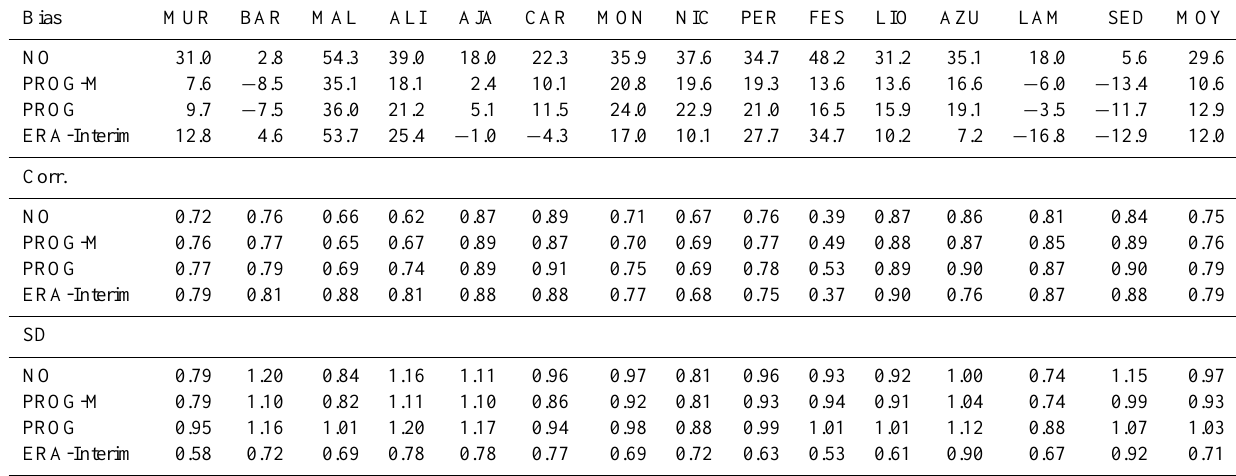
Table 4. Evaluation of daily SSR simulated by NO, PROG-M, PROG and ERA-Interim against 14 ground-based measurements located around the Mediterranean basin, in terms of bias (Wm − 2 ), temporal correlation coefficient and standard deviation (SD) ratio. Bias MUR